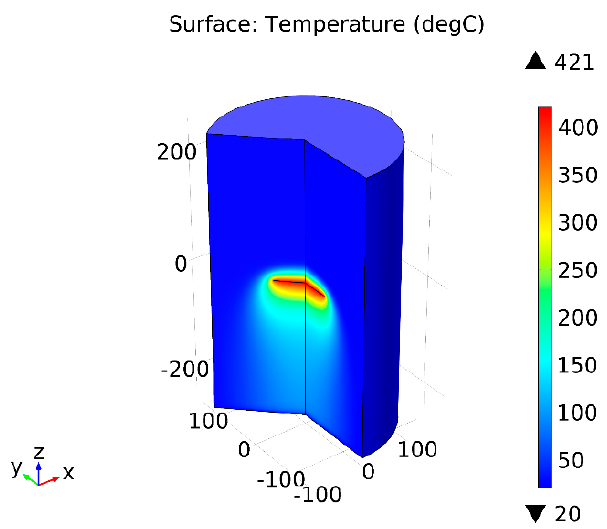
Figure A3. The simulation result of heat transfer of the chamber and the wafer.